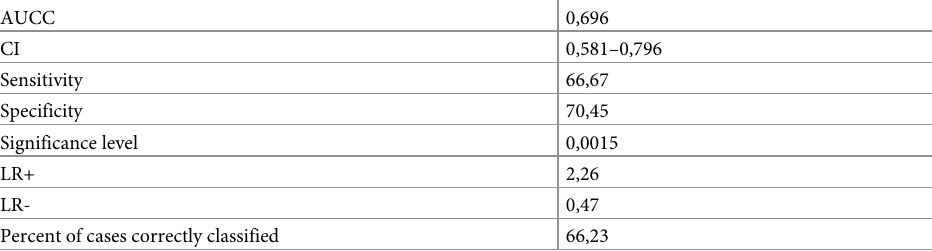
Table 5. Performance characteristics of a clinical-genetic model (ABO, BMI, C_rs5985, C_rs6025, Protein S) for predicting adverse obstetric